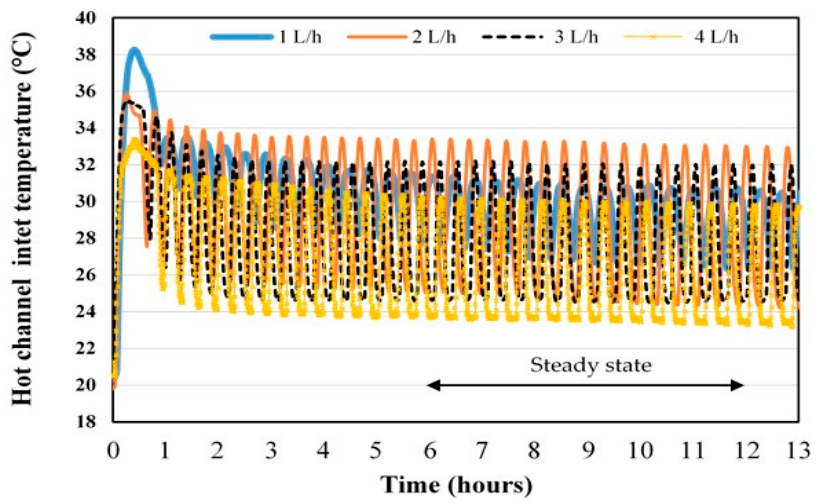
Figure 14. Evolution of the inlet temperatures of the hot channel in controlled mode. Table 3. Average hot feed temperature and temperature difference between on/off in pseudo-steady state.